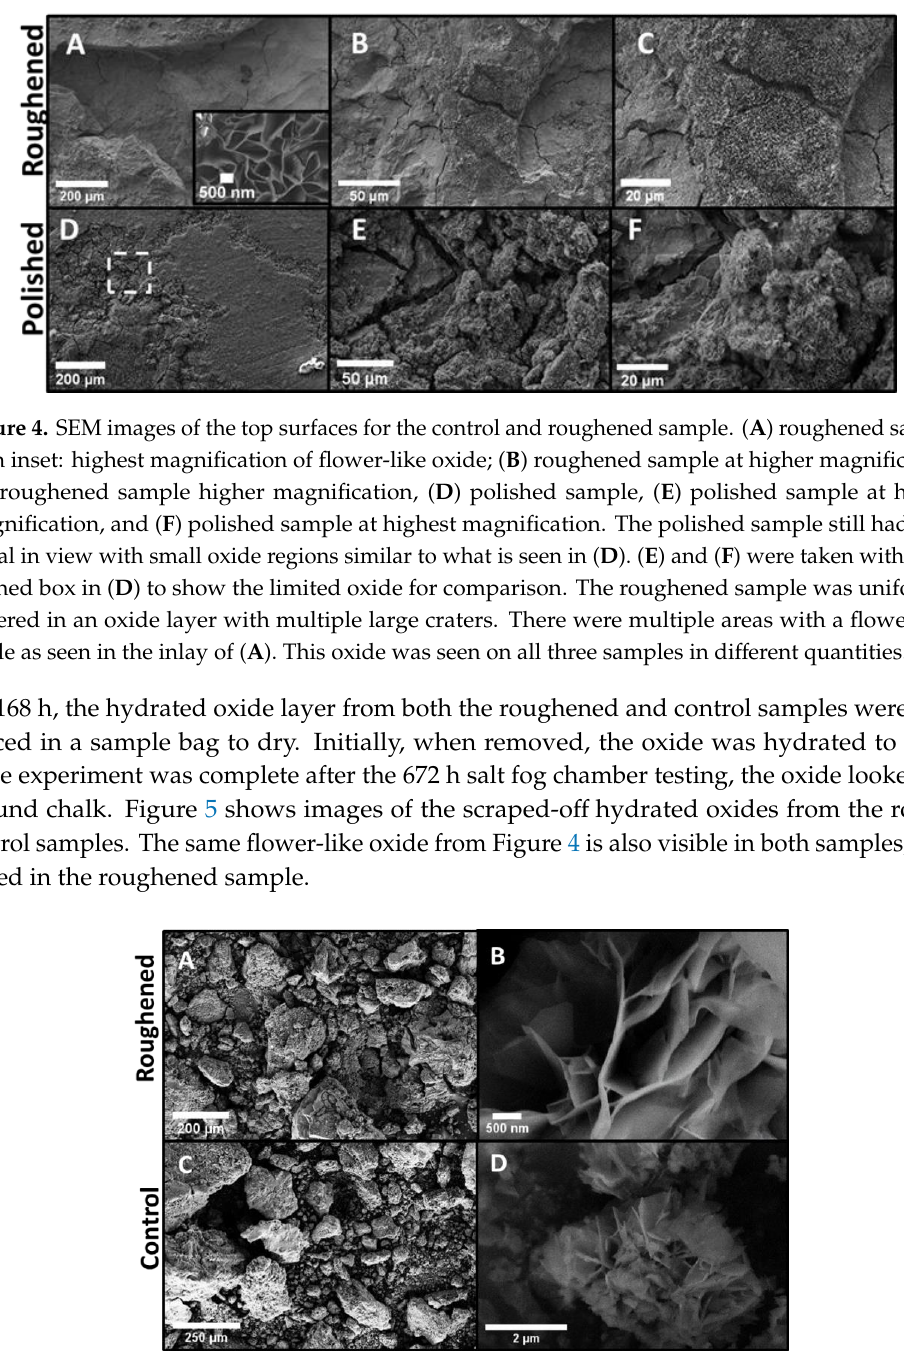
Figure 5. The hydrated oxide layer that formed on the control and roughened samples was scraped off every weight measurement for consistency. ( A ) roughened sample oxide, ( B ) roughened sample oxide at higher magnification, ( C ) control sample oxide, and ( D ) control sample oxide at higher magnification. On both samples the flower-like oxide seen on the top surfaces in Figure 4 is also present in these images. This indicates the flower-like oxide is a characteristic of the hydrated oxide layer.